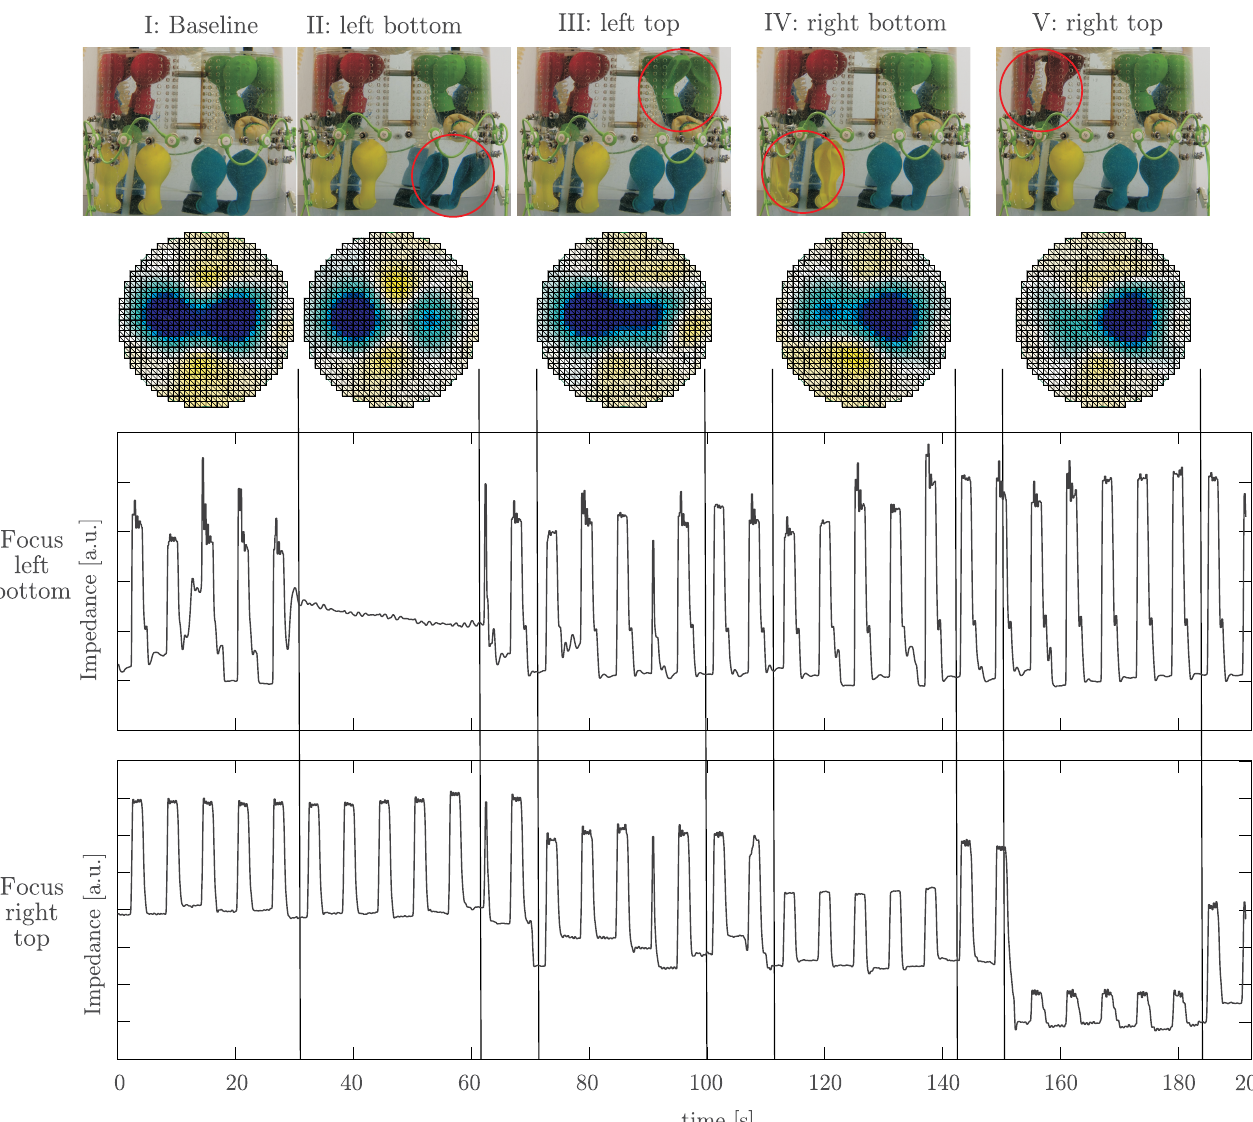
Fig.8: Result of the experimental validation at the water phantom in five phases (I – V). At each phase, the balloons, which represent specific lung lobes, were disabled in the respective region as highlighted in the second row. The corresponding EIT image is shown for each phase. The images show a difference to the baseline measurement. However, no information on the vertical location of the disabled region can be extracted. Below the images, the filtered raw data of two focused electrode configurations (left bottom and right top) is shown. The location of the disabled balloons can be clearly seen in the respective focused impedance